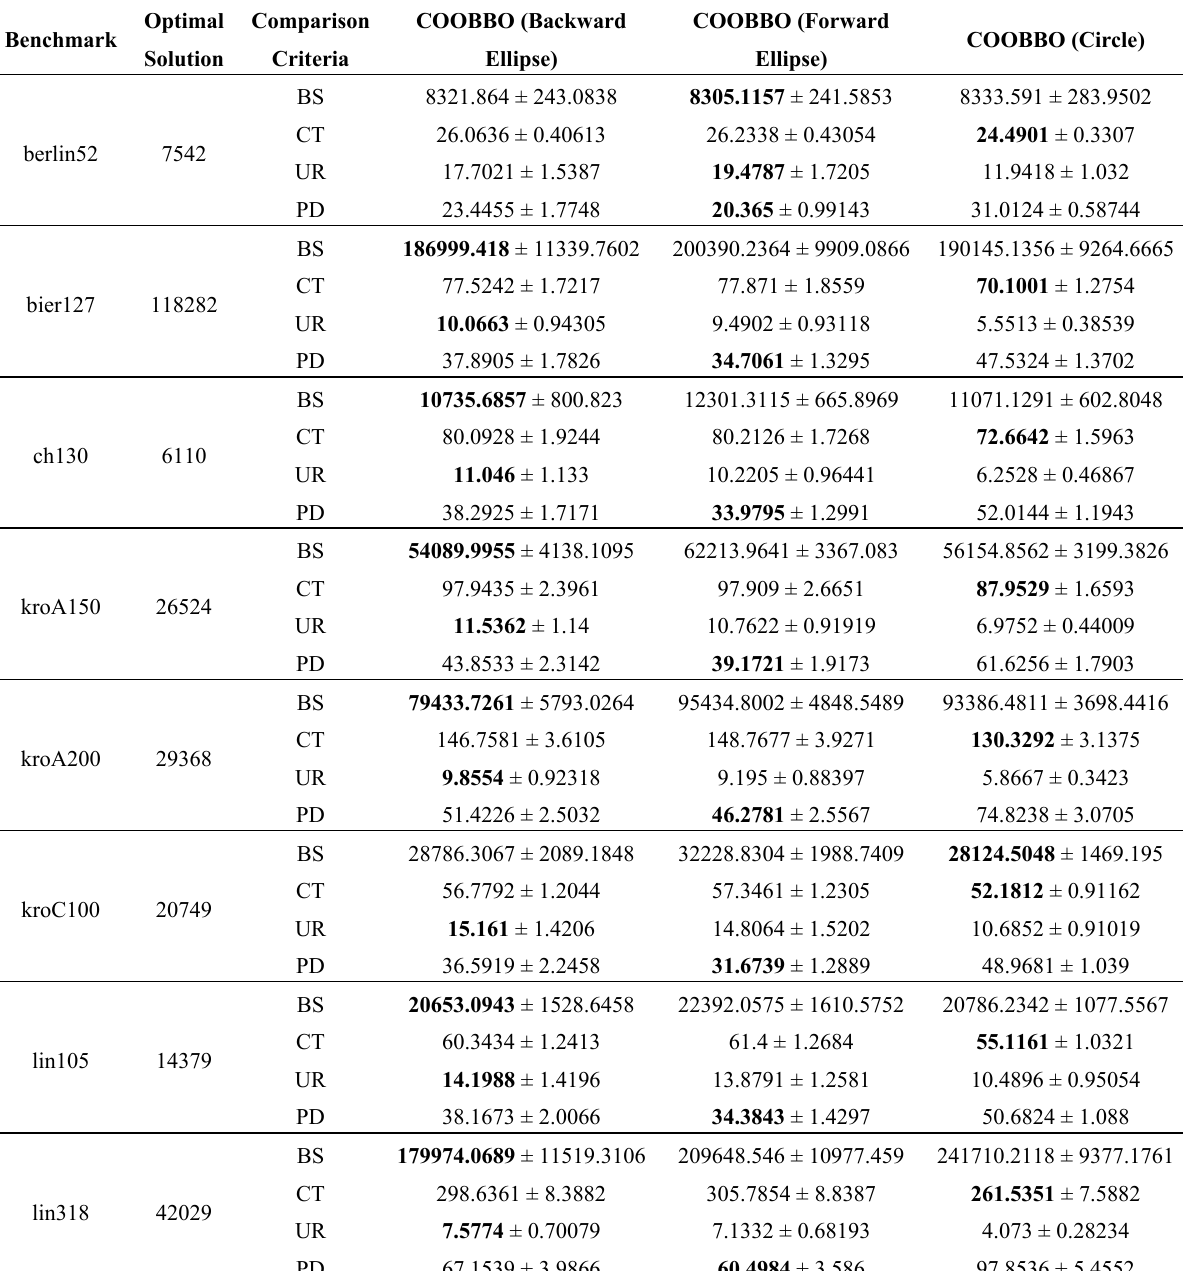
Table 4. Performance comparison of different